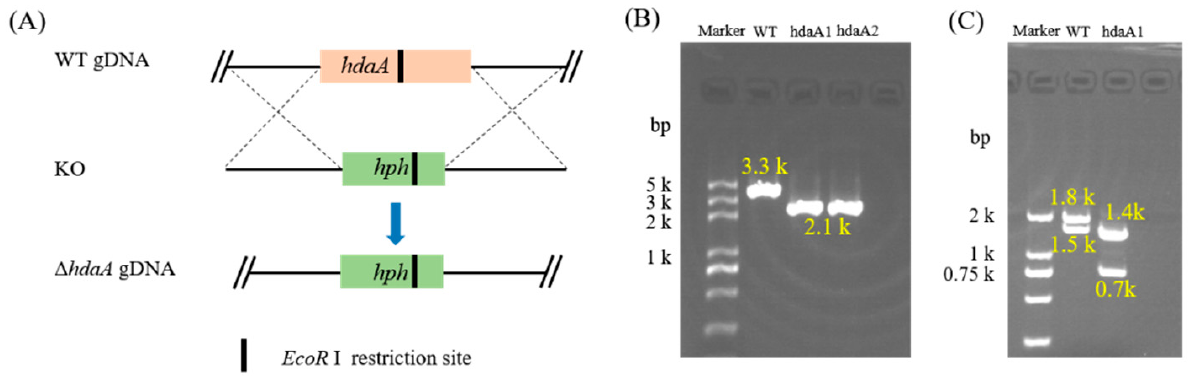
Figure 1. ( A ) Knockout of histone deacetylase gene hdaA . WT gDNA: The genome of wild-type strain; KO: Knock out; ∆ hdaA gDNA: The genome of ∆ hdaA mutant strain. ( B ) Diagnostic PCR amplification. ( C ) Restriction analysis of PCR products of WT and ∆ hdaA strains. 3.2. Analysis of Phenotypic and Secondary Metabolite Profile of Δ hdaA Mutant of A. terreus RA2905 The Δ hdaA mutant strain displayed phenotypic differences compared to WT when cultured